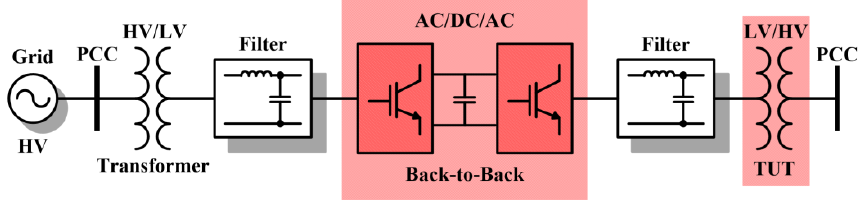
Figure 1. Test structure with load and full load converter.